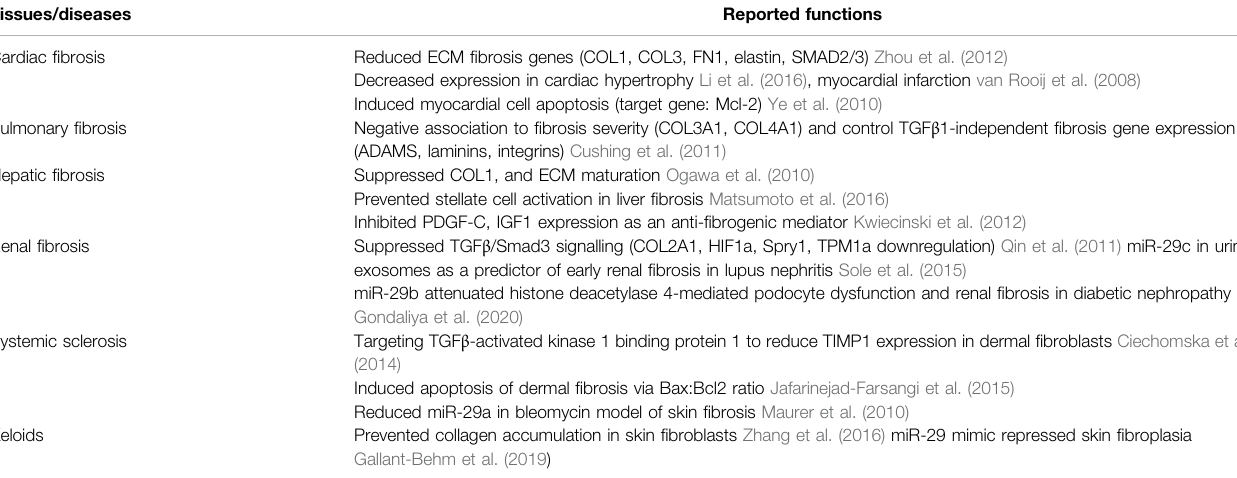
TABLE 2 | miR-29 expression in fi brotic diseases. Tissues/diseases Reported functions Cardiac fi